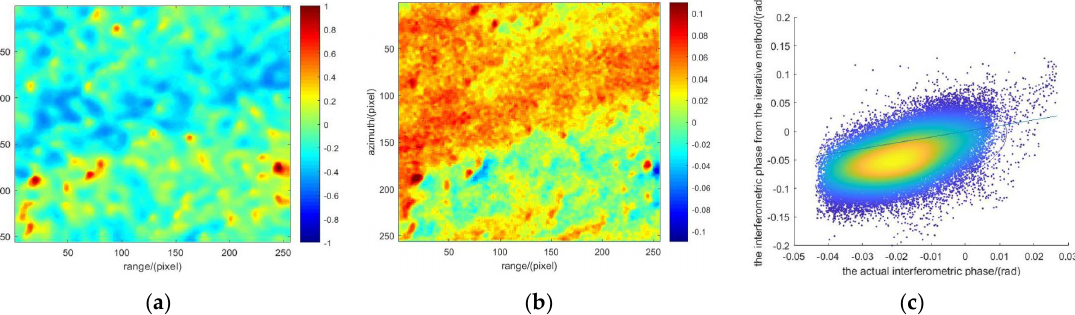
Figure 22. Results of the iterative method: ( a ) the calculated current filed, ( b ) the simulated interferometric phase, and ( c ) the scatter density map of simulated and extracted interferometric phases.